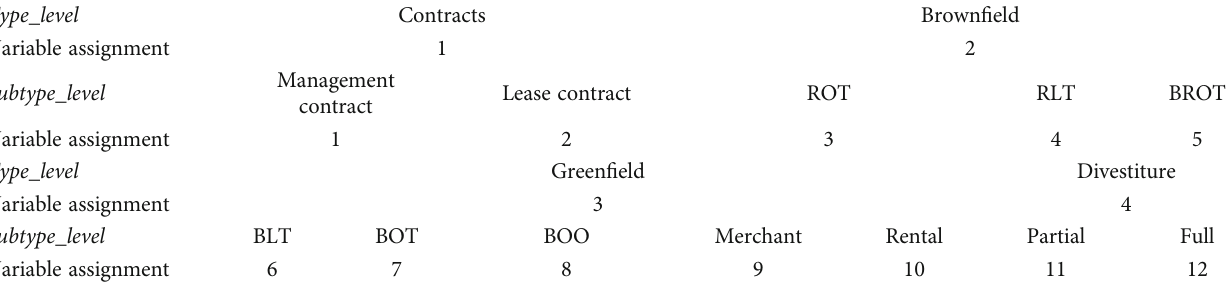
Table 3: Type/subtype of sampled Green PPP projects and their variable value.